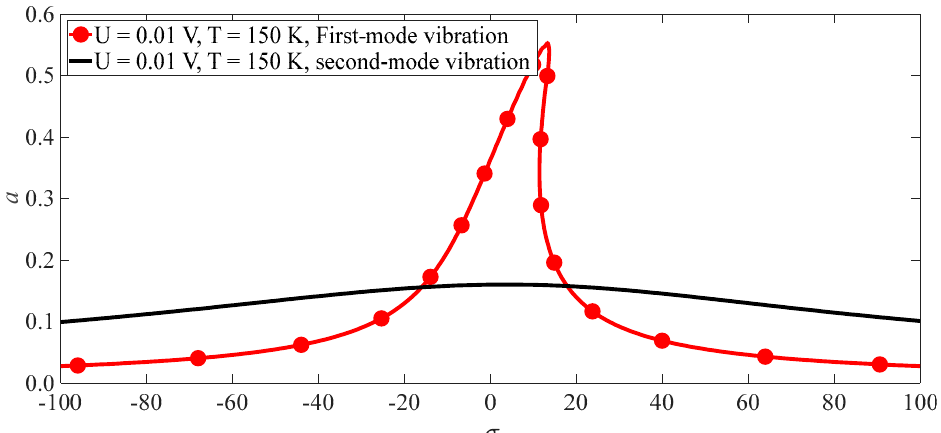
( Figure 5. Frequency − Response curves of the first mode with ( c ) = ( 5, 4.95 ) and the second 1 , f 1